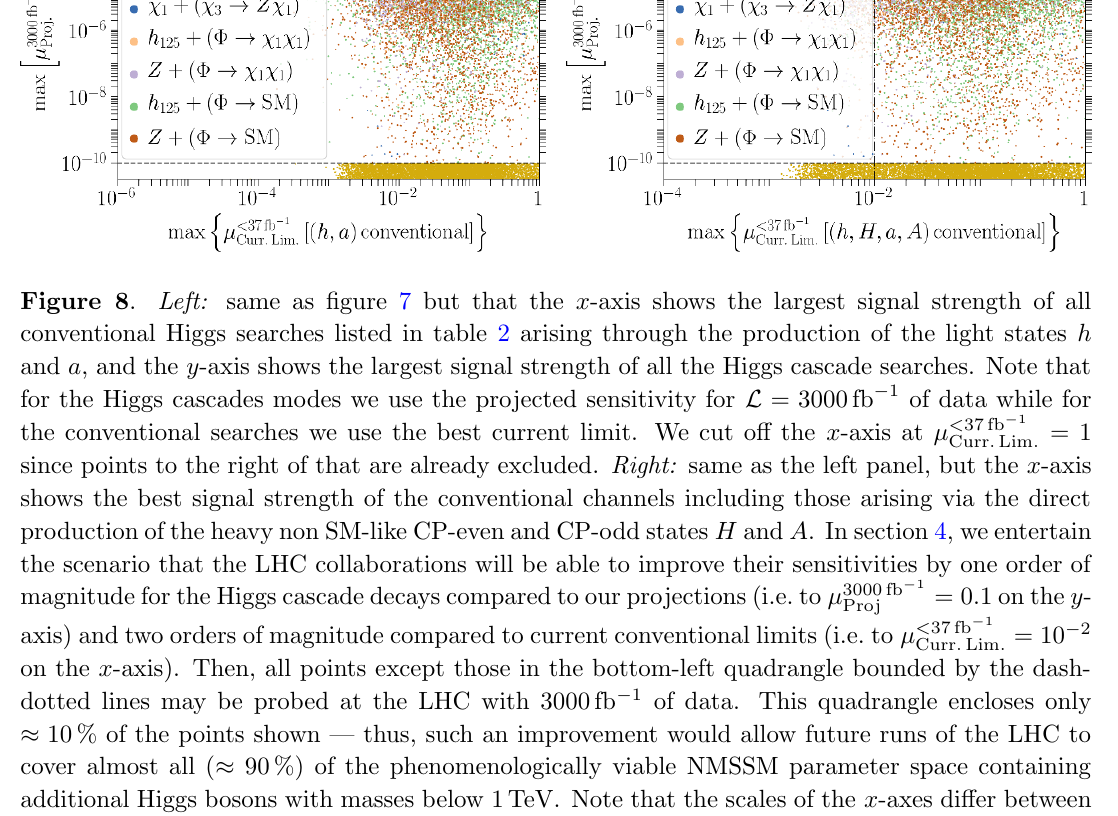
= 1 Curr : Lim : = 0 : 1 on the y - Proj = 10 (cid:0) 2 Curr : Lim :